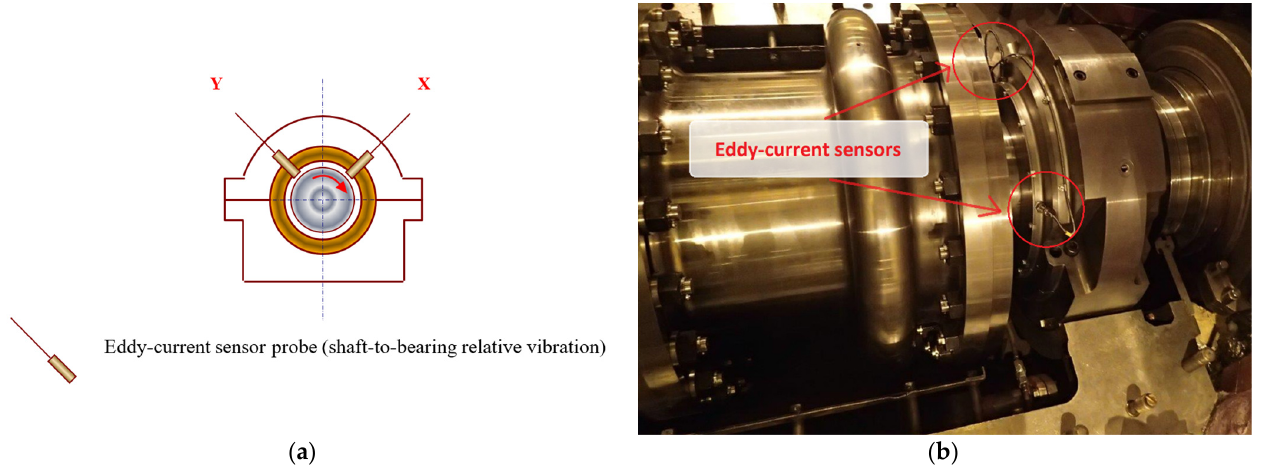
Figure 1. Eddy ‐ current sensor arrangement: ( a ) schematic sensor layout; ( b ) actual placement of the sensors mounted inside on the turbo ‐ set.